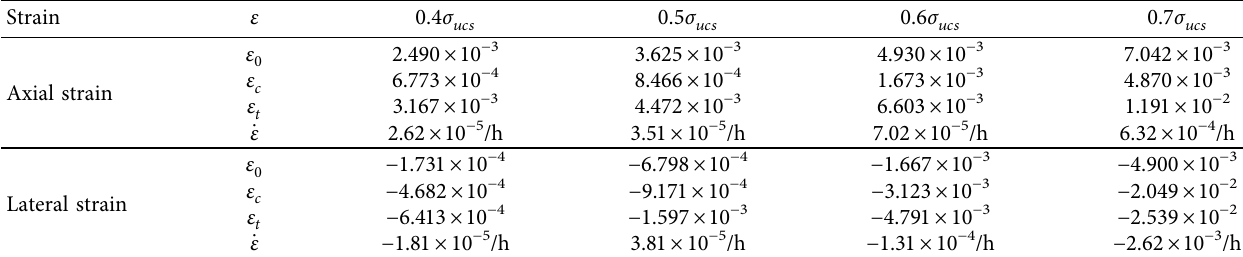
Table 2: Creep parameters of natural sample under diferent stress levels.